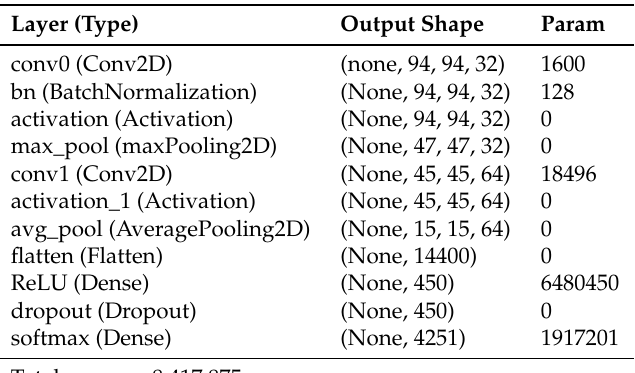
Table 4. Architecture of the implemented network.